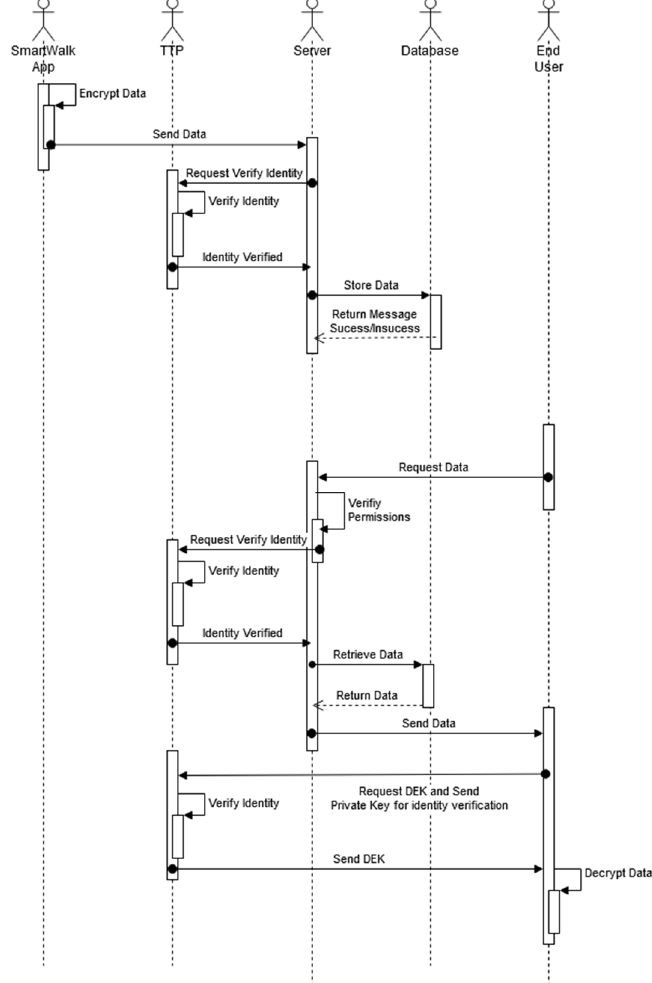
Figure 3. Data transmission diagram.